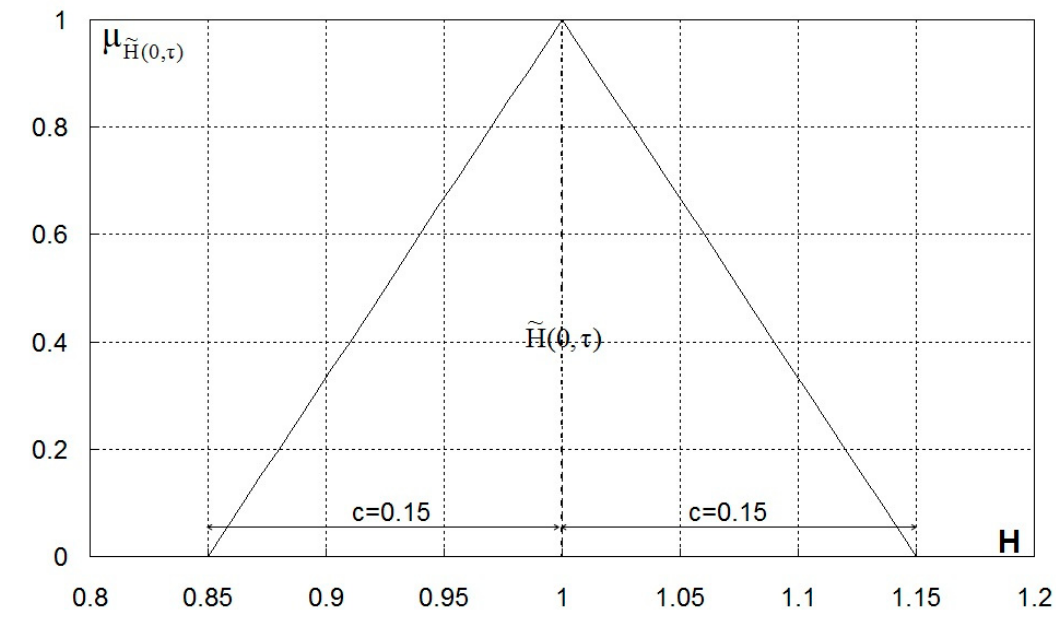
Figure 2. Fuzzy boundary condition